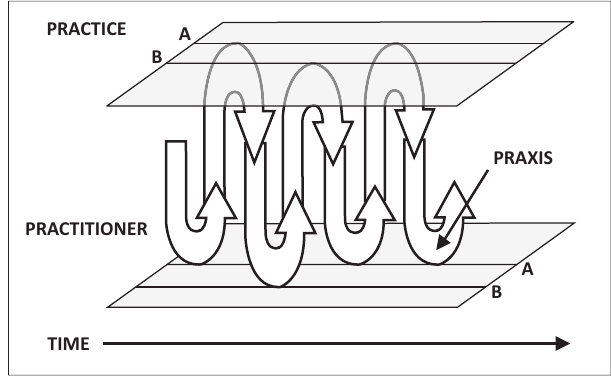
FIGURE 1: Strategising DNA